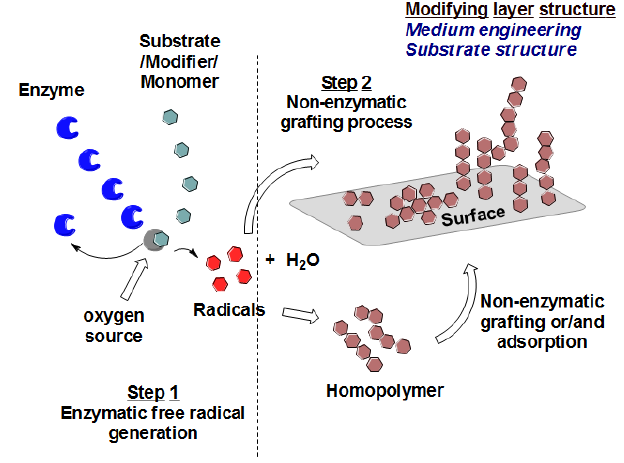
Figure 2. Schematic representation of enzyme-catalyzed modification of PES surfaces .